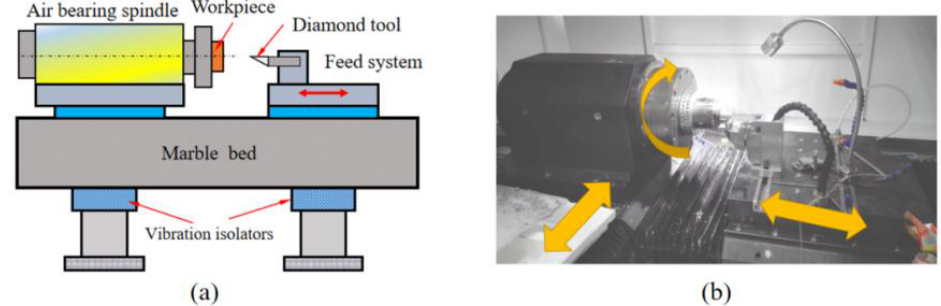
Figure 9. Structure of ultra-precision machine tools: ( a ) 3D model, ( b ) physical machine.